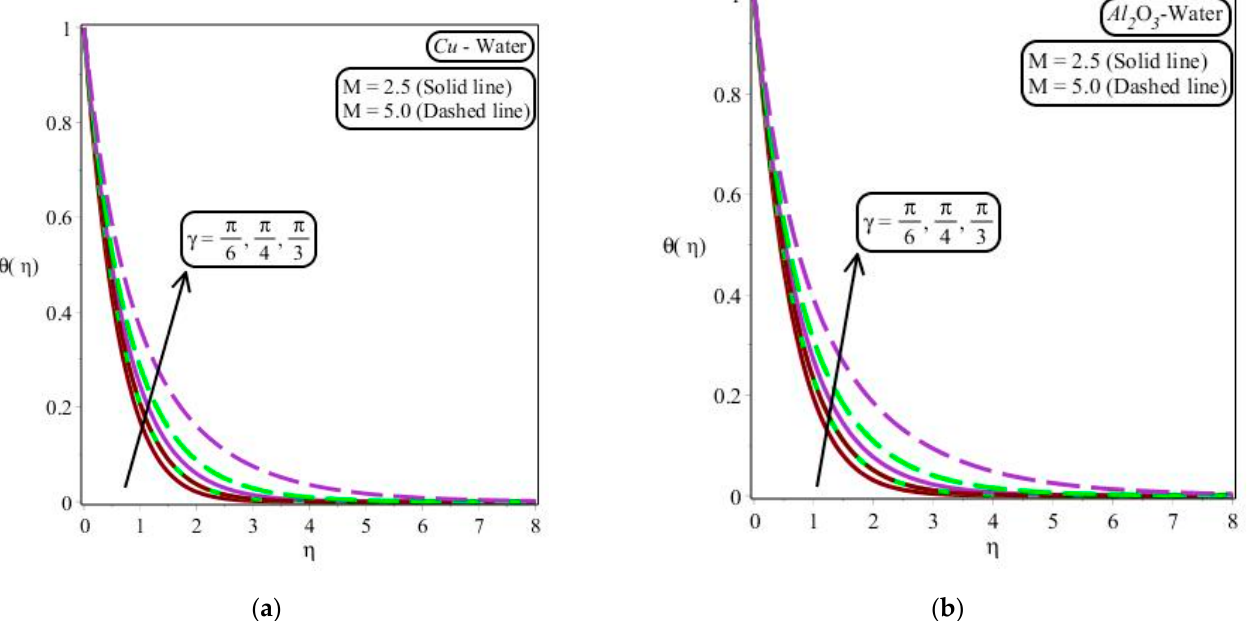
Figure 7. ( a , b ) Impact of N on temperature profile with K 1 = 0.7, β = 0.7, γ = π /4, and ϕ = 0.2.